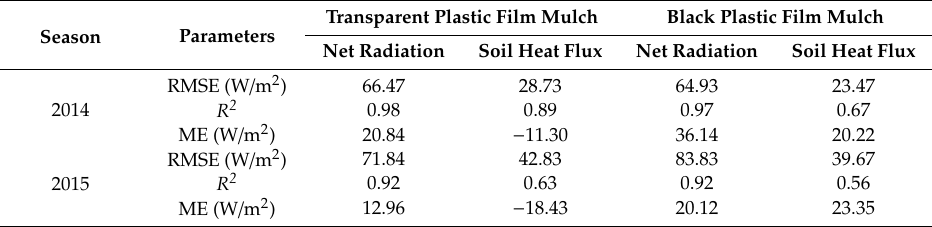
Figure 9. Comparison of the observed and simulated hourly net radiation of the transparent plastic film mulch (TM) treatment and black plastic film mulch (BM) treatment at Wuwei, China, in 2015. Table 6. The root mean square errors (RMSE), coefficient of determination ( R 2 ), and mean errors (ME) in simulated and observed hourly net radiation and soil heat flux for the transparent plastic film mulch and black plastic film mulch treatments at Wuwei, China.